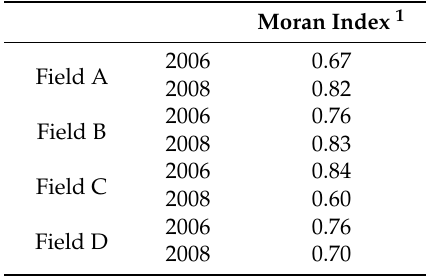
Table 2. Spatial autocorrelation analysis in the four fields studied during 2006 and 2008.